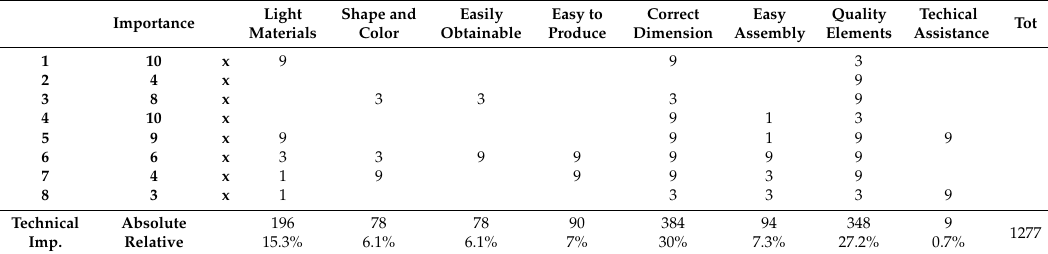
Table 7. Relationship